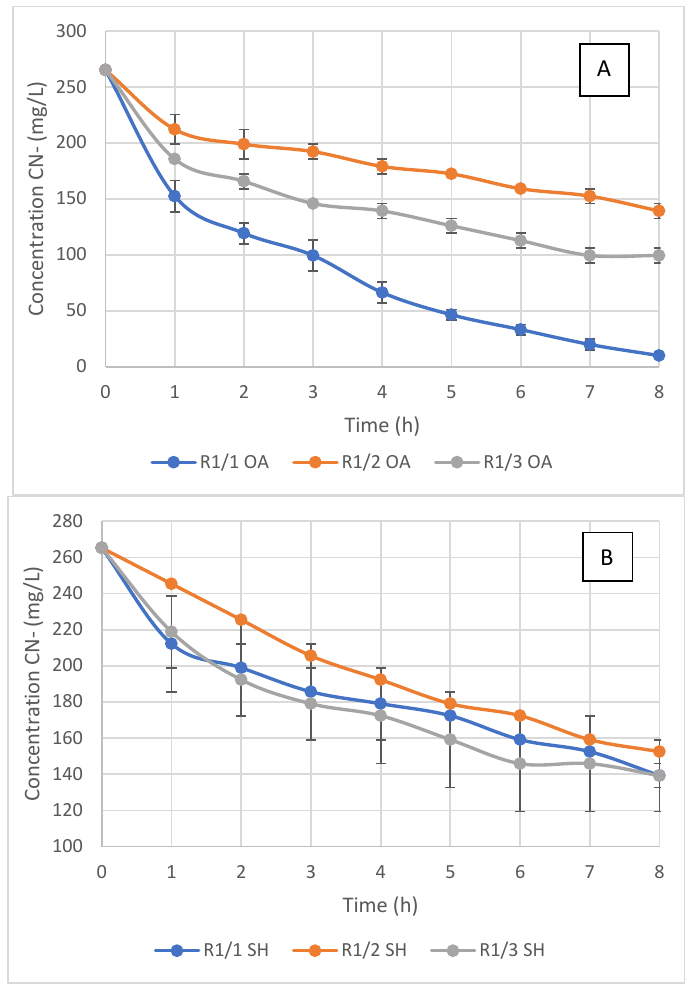
Fig. 7: Evaluation of the mass ratio nickel ferrite/activated carbon (Ratios 1/1, 1/2 and 1/3) in the preparation of catalysts and their influence on the oxidation of cyanide ion (15 g/L, 180 NL/h, 5.5-8.5 mg O 2 /L, 800 rpm). (a) by hydro-chemical pathway (OA). (b) by co-precipitation pathway (SH) Table 3: Proximate analysis of the composites obtained